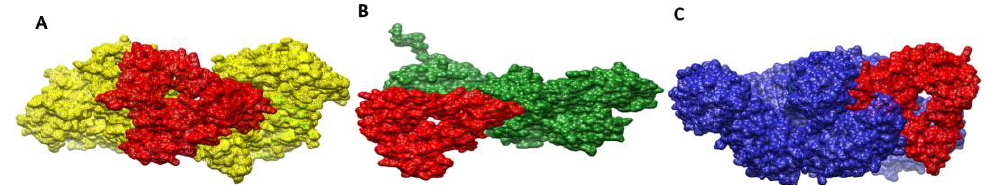
Figure 10. Docked conformation of vaccine (represented by the red mesh) to MHC-I (represented by the yellow mesh) ( A ), MHC-II (represented by the dark green mesh) ( B ), and TLR4 (represented by the blue mesh) ( C ).